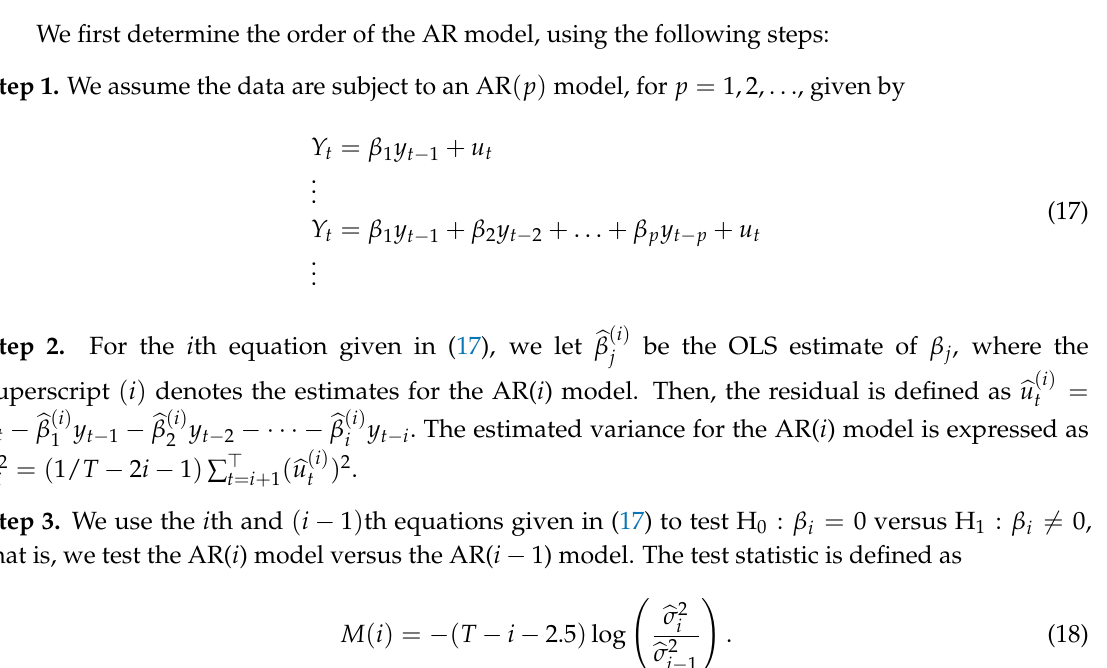
Figure 3. CVX weekly log-returns.